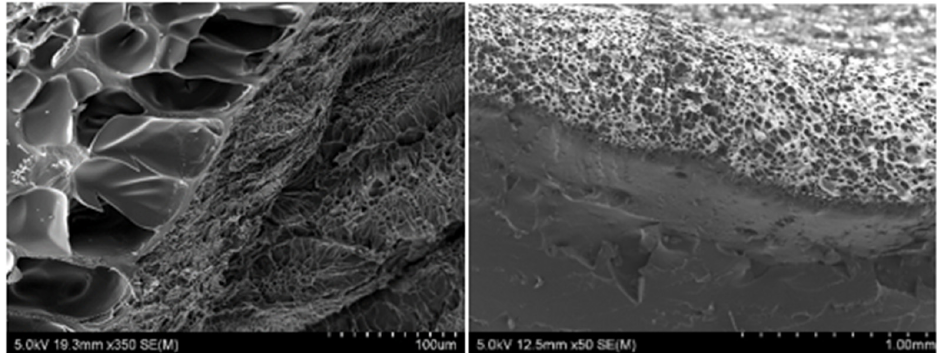
Figure 2. PAAm-Alg bilayer hydrogels: cross-section view.